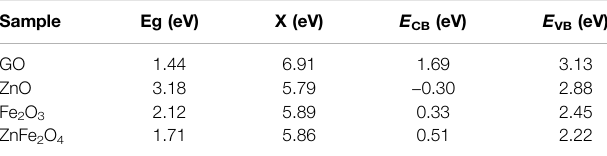
TABLE 1 | Conduction band, valence band potential, electronegativity, and Eg values of GO, ZnO and Fe 2 O 3 , and ZnFe 2 O 4 . Sample